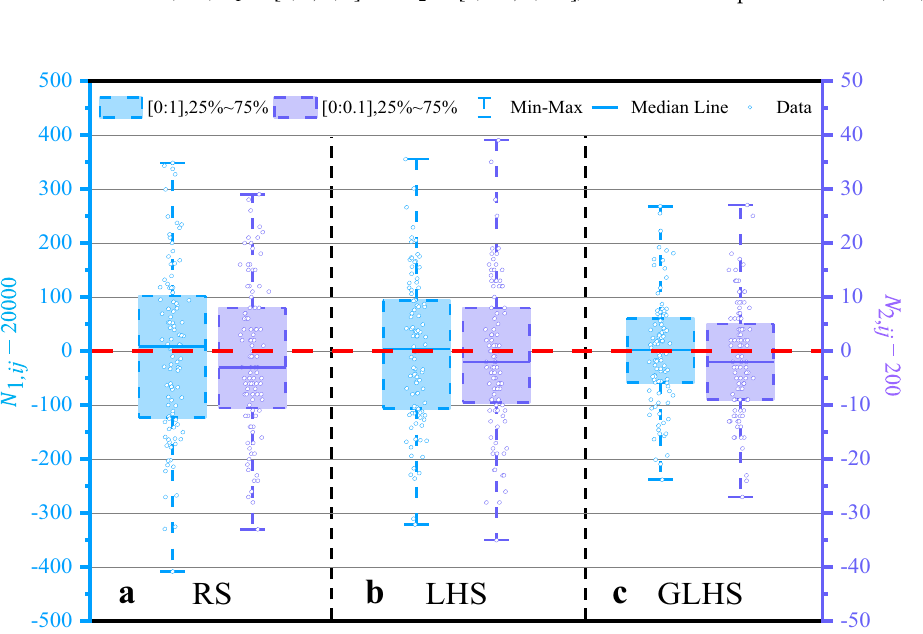
0, 1 0, 1 , and the purple Y-axis on the = [ ; ] 0, 0.1 0, 0.1 . The box represents = [ ; ]